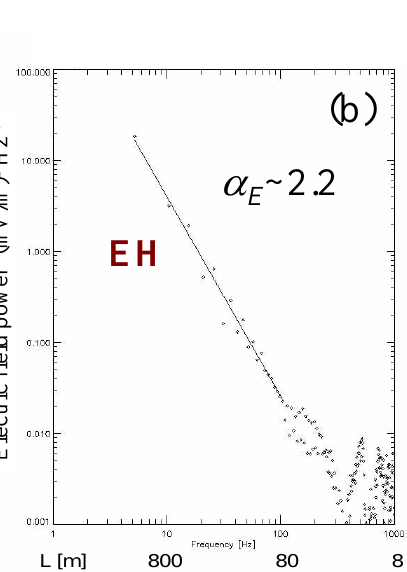
Fig. 2. Power spectra of the electron density ( a ) and horizontal electric field fluctuations, ( b ) inside the ionospheric turbulence (IT) to be associated with the ESF observed by the Aureol-3 satellite during the 8 June